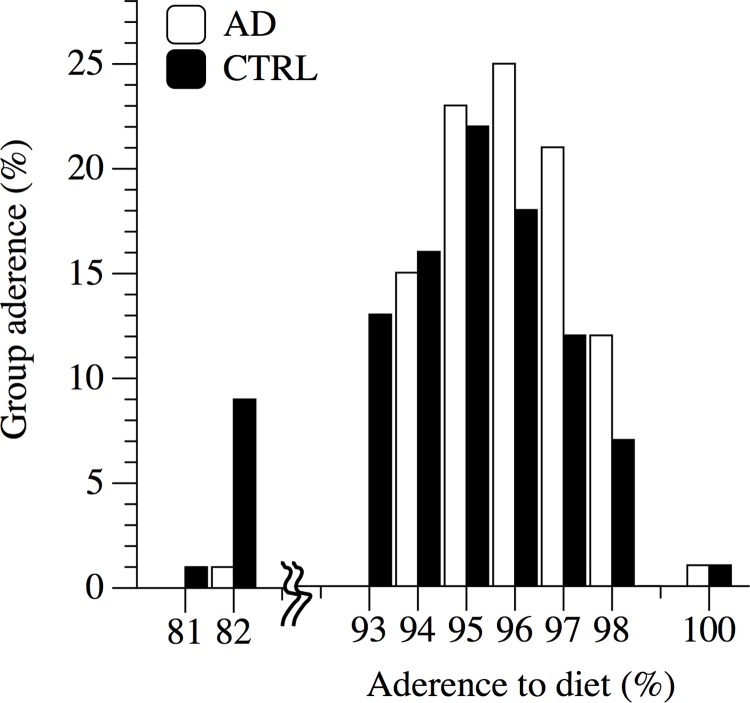
Distribution of diet-adherence in patients with AD and CTRL.